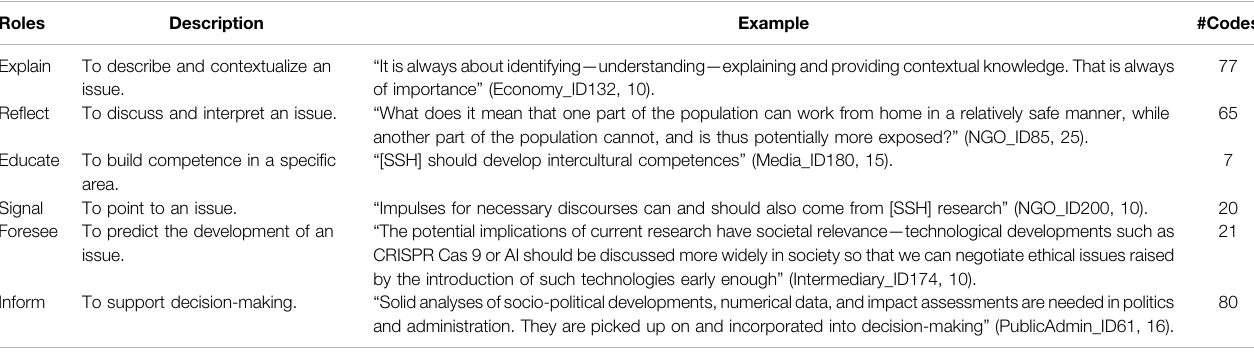
TABLE 3 | Societal functions of SSH